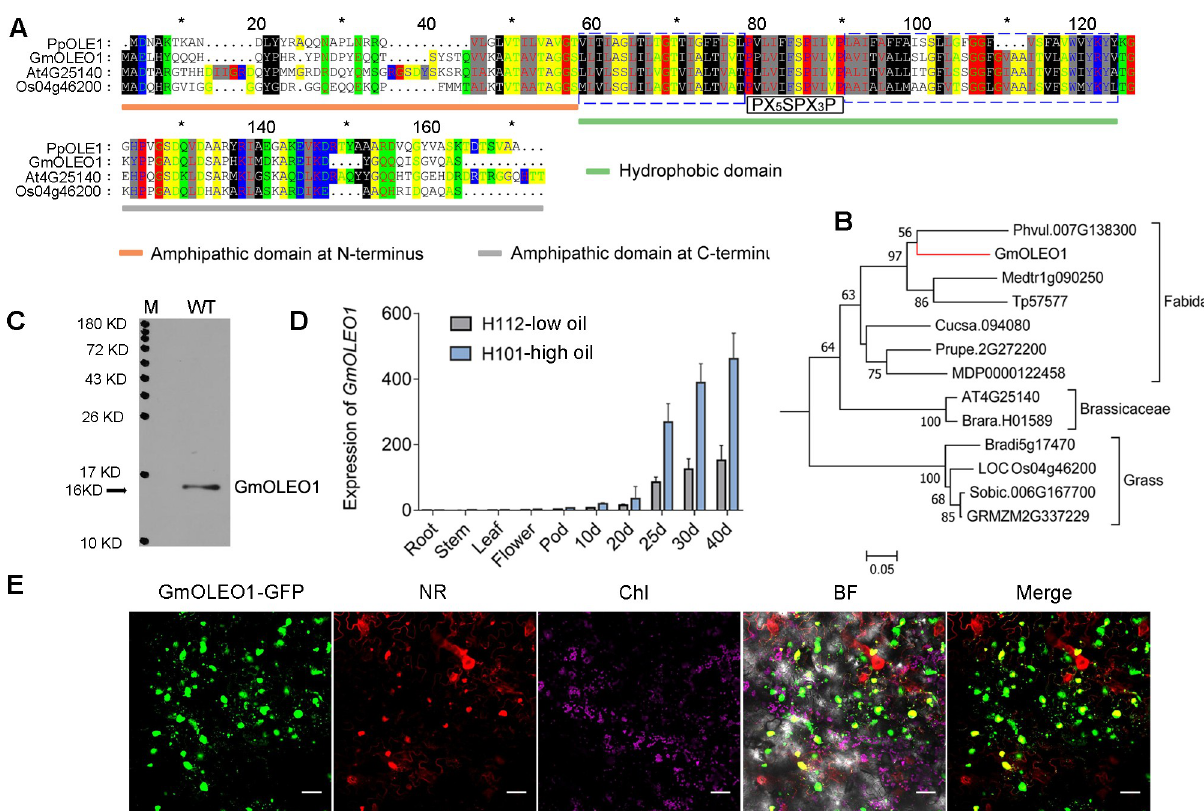
Fig 2. Sequence and expression analysis of GmOLEO1 . A, Domain structure and full-length amino acid alignment of representative OLE protein orthologs, including the structurally well-studied PpOLE1 ( Physcomitrella patens ), GmOLEO1, At4G25140 ( Arabidopsis thaliana ), and Os04g46200 ( Oryza sativa ). The amphipathic domains at the N-terminus and C-terminus are highlighted by blue and gray solid boxes, respectively. The conserved hydrophobic domain between two amphipathic proteins is shown by a red solid box. Dotted boxes indicate the two hydrophobic arms that can form a hairpin (blue in D); (PX 5 SPX 3 P) indicate the conserved sequence that forms a loop (black in D). B, Phylogenetic relationship between GmOLEO1 and its orthologs. All amino acid sequences were retrieved from Phytozome (https://phytozome.jgi.doe.gov). C, Gel image showing the molecular mass of GmOLEO1 (15.76 KD) using Western blot. M, protein marker, WT, proteins extracted from developing seeds of Williams 82 at 40 DAF. D, The relative transcript level of GmOLEO1 in different soybean tissues and developing seeds at 10, 20, 25, 30, and 40 days after flowering between the high-oil soybean cultivar H101 and low-oil cultivar H112; �� P < 0.01 t -test. E, Subcellular localization analysis of GmOLEO1 . GmOLEO1 -GFP signal (GFP) colocalizes with oil bodies stained with Nile Red (NR). Chl represents chloroplast, BF represents bright field, and Merge shows both GFP and NR. Scale bar, 20 μ m. White arrows indicate oil